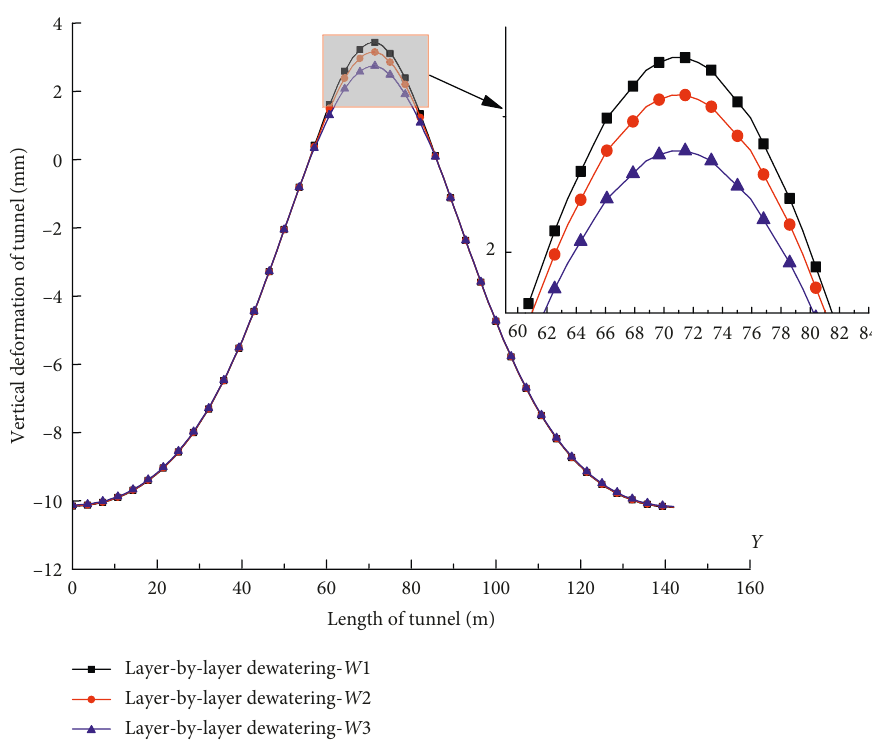
Figure 13: Tunnel deformation under different excavation methods with layer-by-layer